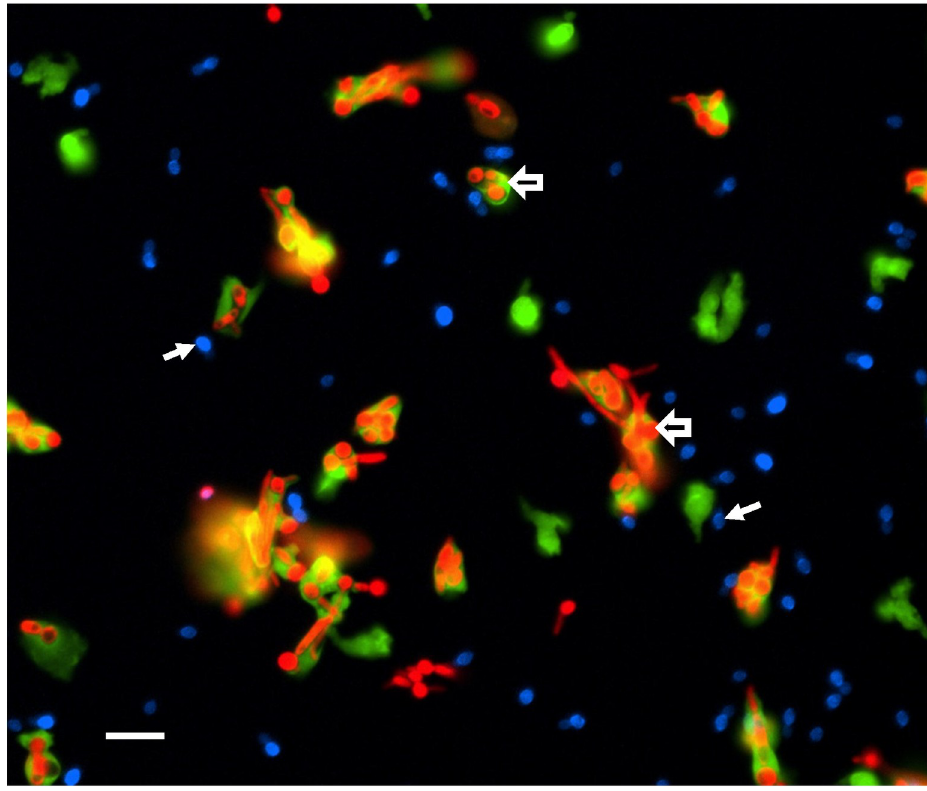
Fig 1. Human neutrophils fail to engage Candida auris . Calcein AM-labeled human neutrophils (green) were cocultured with red fluorescent protein-tagged C . albicans (red) and calcofluor white-stained C . auris (blue) for 30 min. Neutrophils preferentially engaged C . albicans , ignoring C . auris . Open arrows point to neutrophils phagocytosing C . albicans . Closed arrows show C . auris cells. Few neutrophils engage C . auris in the presence or absence of C . albicans . Measurement bar represents 10 μ